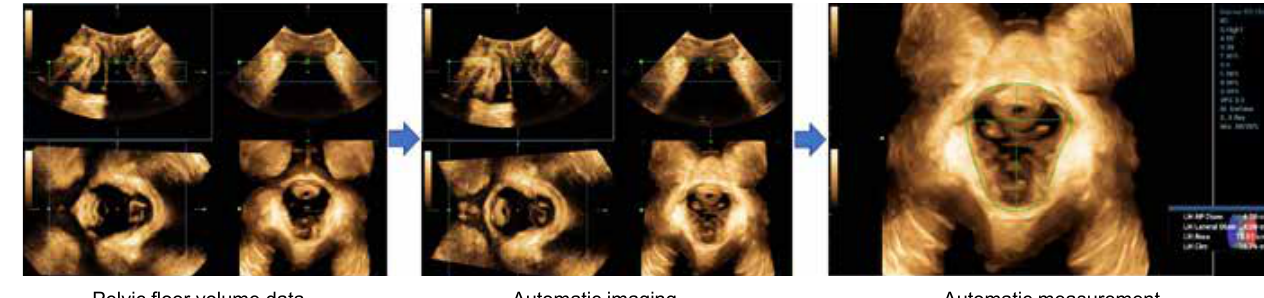
Pelvic floor volume Figure 1 Automatic LH segmentation and measurement by Smart-pelvic.